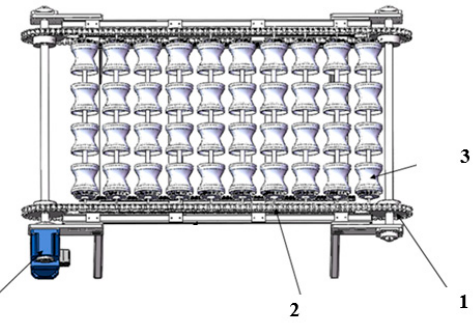
Figure 3. Turnover detection conveyor. (1—sprockets, 2—chains, 3—sponge rollers, 4—motor).